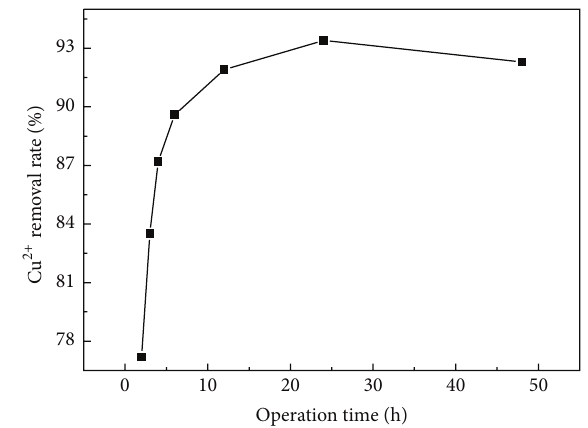
Figure 1: Effect of NaOH concentration (conditions: adsorbent dose = 5g/L, adsorbate conc. = 20mg/L, pH = 5, contact time = 6 h, temp. = 25 ± 1 ∘ C, and stirring rate = 150rpm).